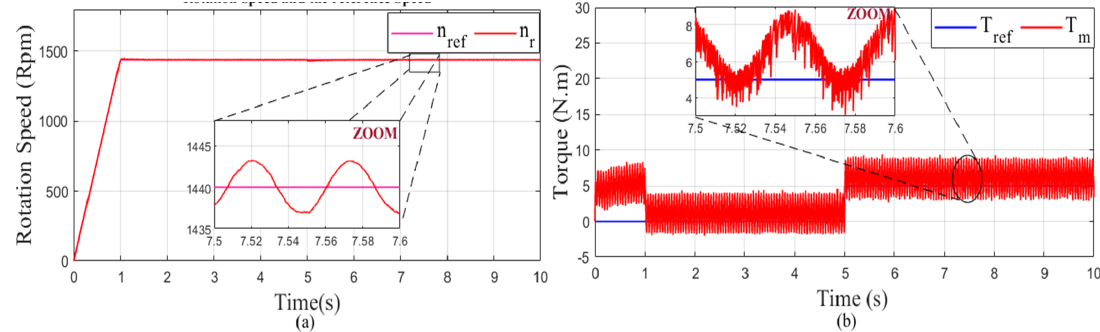
Figure 41. Performances with Ball bearing defect of IM with ANN ‐ DTC control: ( a ) rotation speed and ( b ) motor torque.